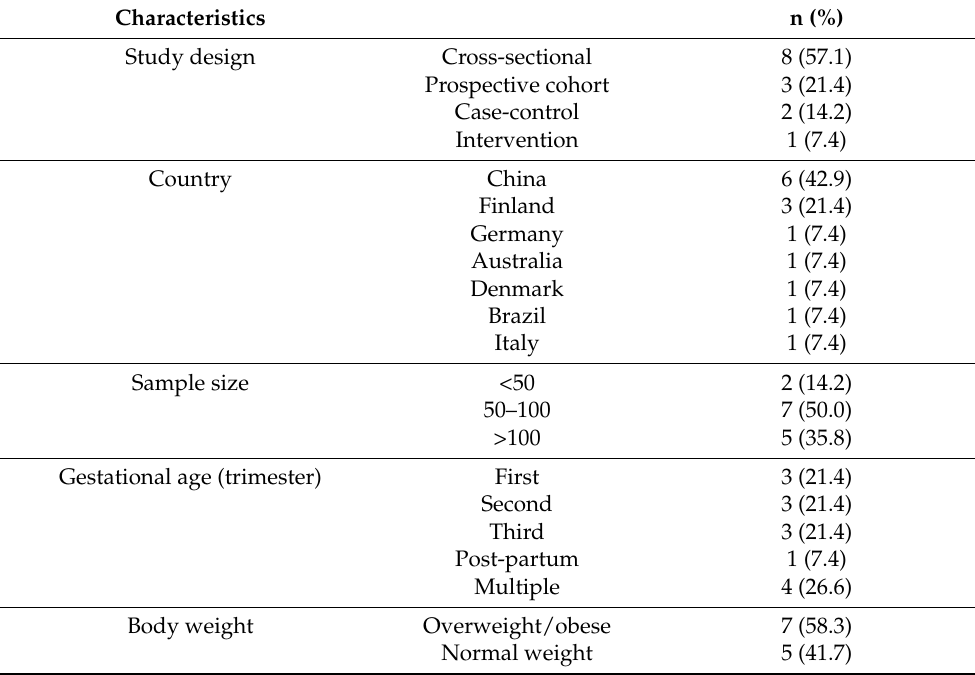
Table 1. Summary characteristics of included studies (n = 14).